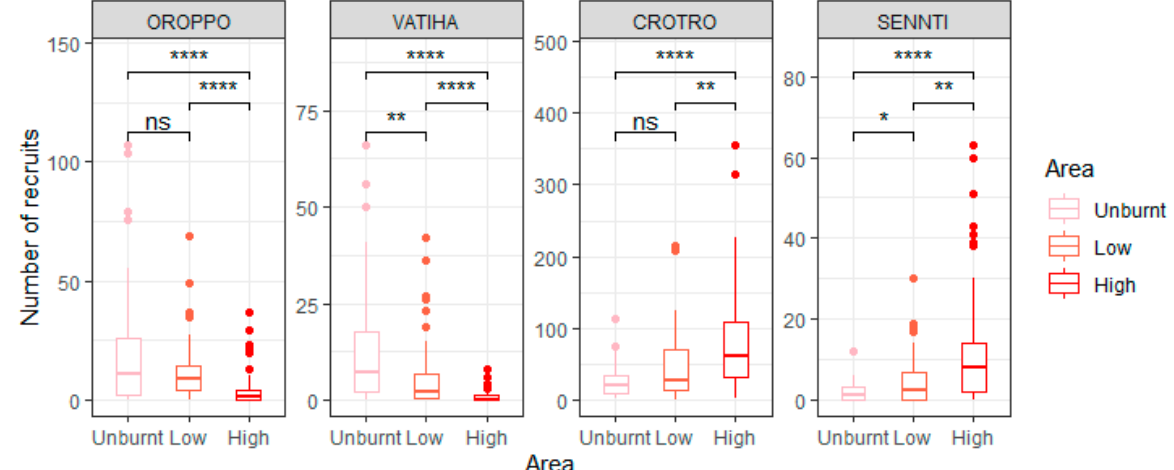
Figure 6. Boxplot of the Kruskal-Wallis test of number of recruits per quadrat across areas of Orophea polycarpa ; OROPPO, Vatica harmandiana ; VATIHA, Croton roxburghii ; CROTRO, Senna timoriensis ; SENNTI in Huai Kha Khaeng Forest Dynamics Plot, Thailand. Note the vertical axis differs among panels. The multiple-pairwise comparison in number of recruits between areas are applied by the Wilcoxon test. Asterisks indicate statistically significant difference: n.s. for p > 0.05; * for p ≤ 0.05; ** for p ≤ 0.01; **** for p ≤ 0.0001.